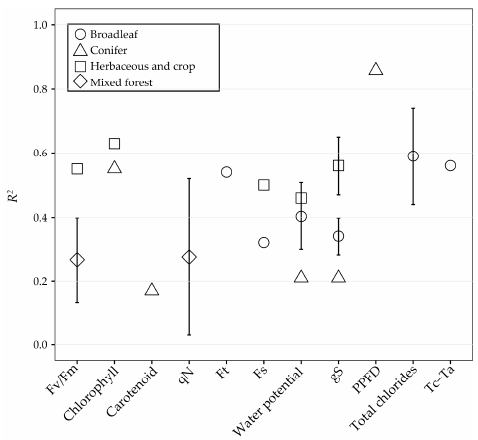
17 of 34 Figure 5. Boxplots of the coefficients of determination of the relationships between PRI and the